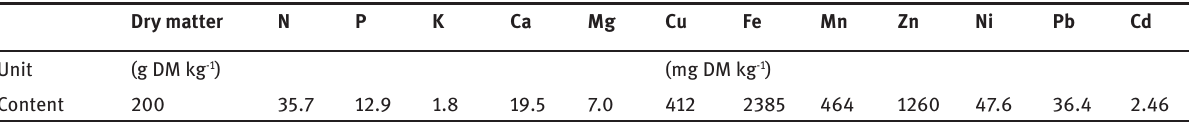
Table 1: Sewage sludge chemical composition. Wrocław Sewage Treatment Plant, Janówek.